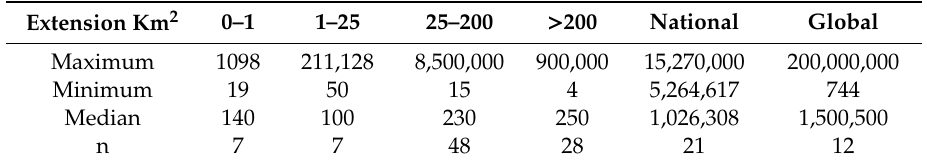
Table 4. Maximum, minimum, and median values of the number of control data used in the studies according to their